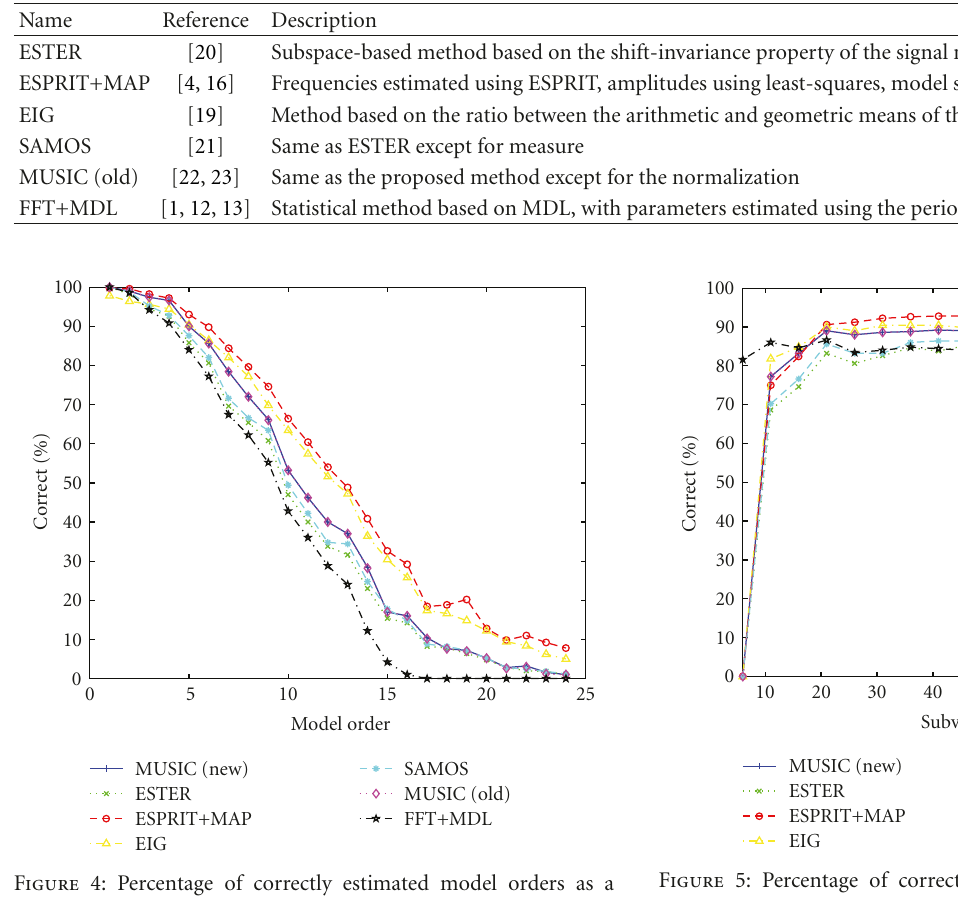
Figure 4: Percentage of correctly estimated model orders as a function of the true order with SNR = 20 dB and N = 100.